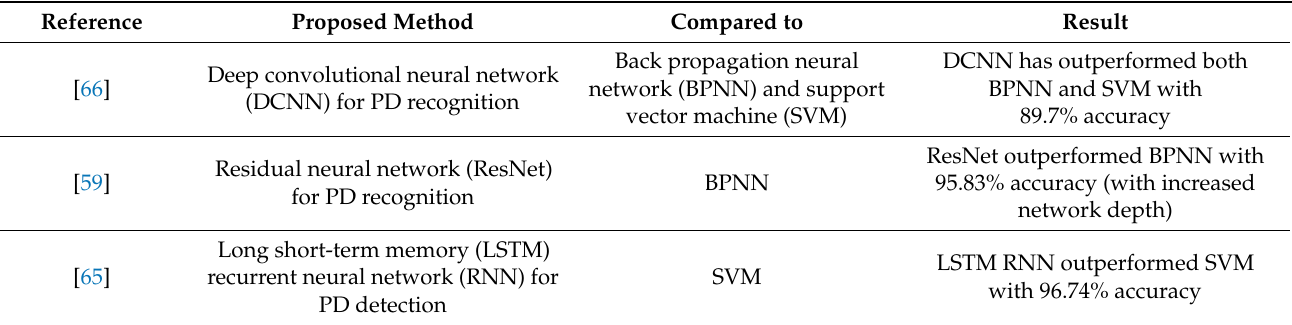
Table 2. Studies containing direct